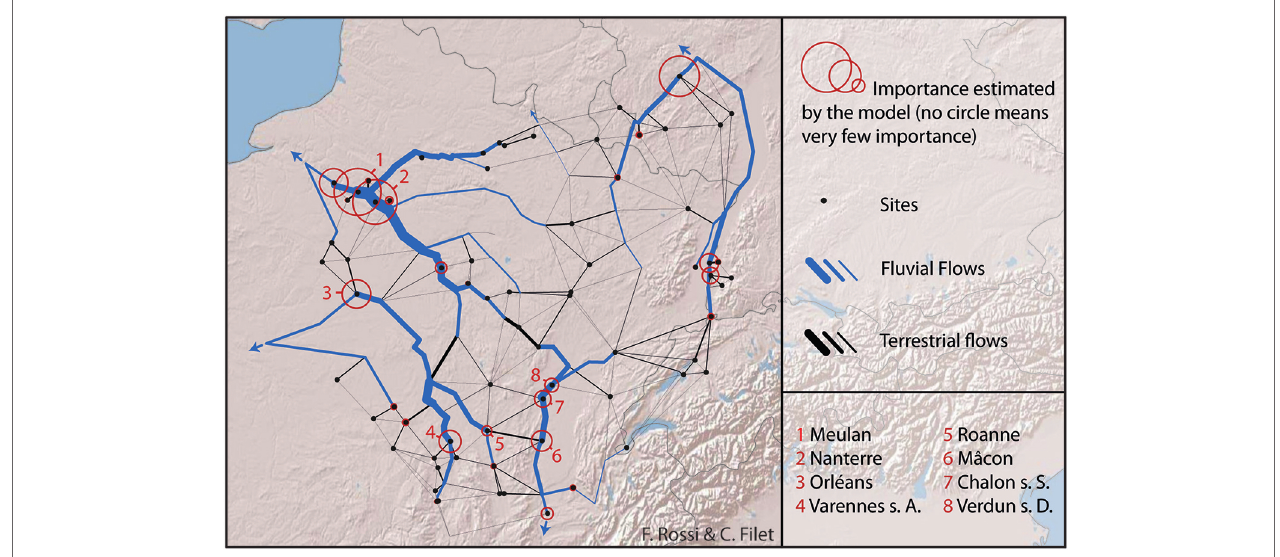
FiGUre 2 | exemplary output for settlements of more than 7 ha and dated from Lt d1 . Created by author (Basemap: Copyright © 2017 Esri. All rights